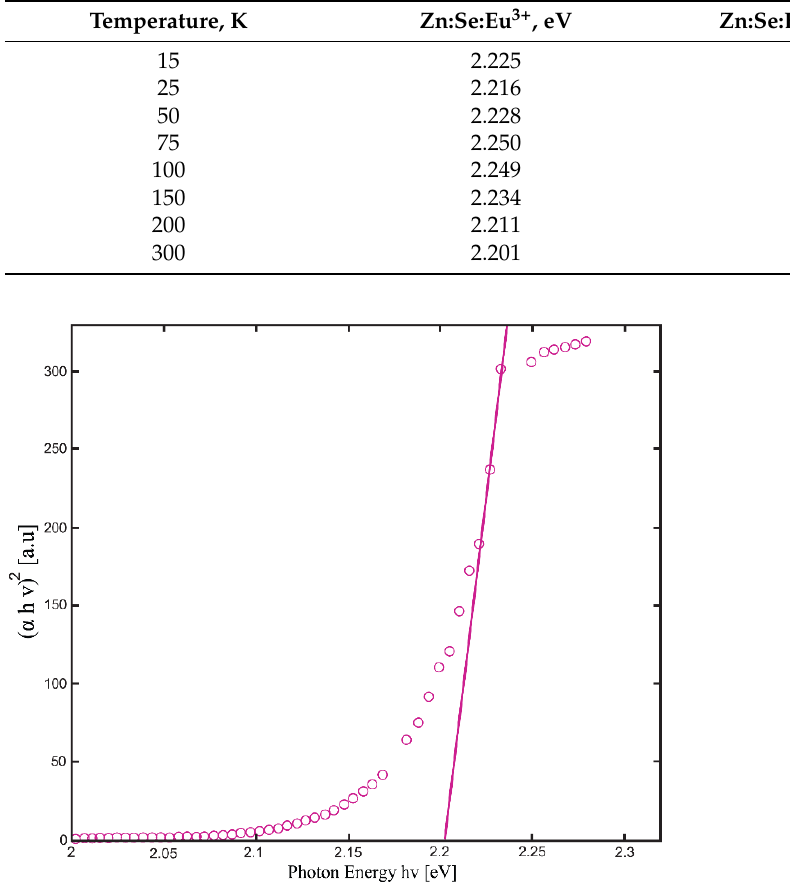
Figure 3. Energy gap calculation plot for ZnSe:Eu 3+ at 300 K. The circles represents the experimental values and the line is the extrapolation of the linear part.